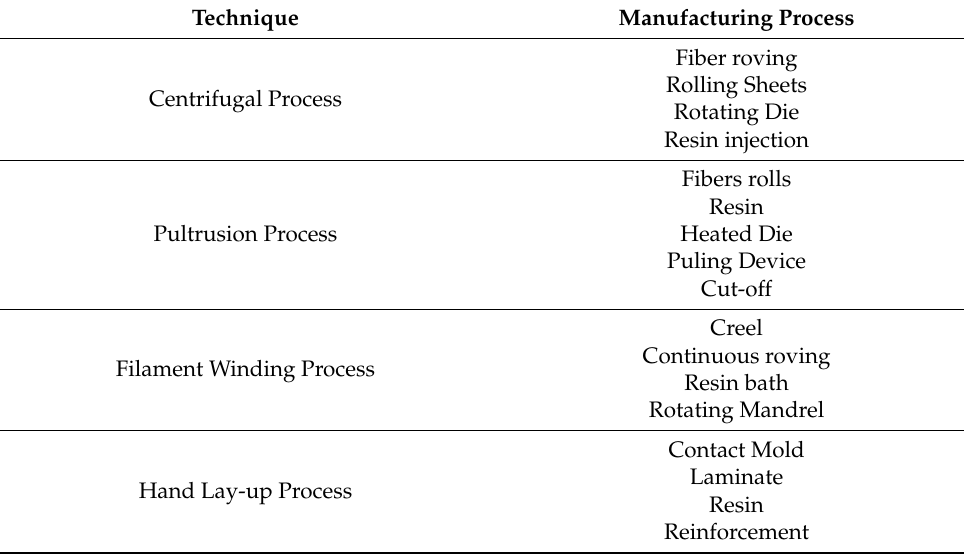
Table 2. Different Techniques of Manufacturing FRP